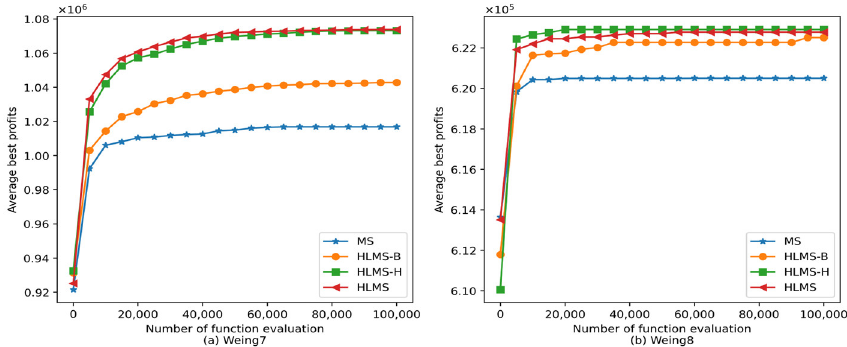
Figure 13. Convergence graphs of MS, HLMS-B, HLMS-H, and HLMS on Weing7 and Weing8.